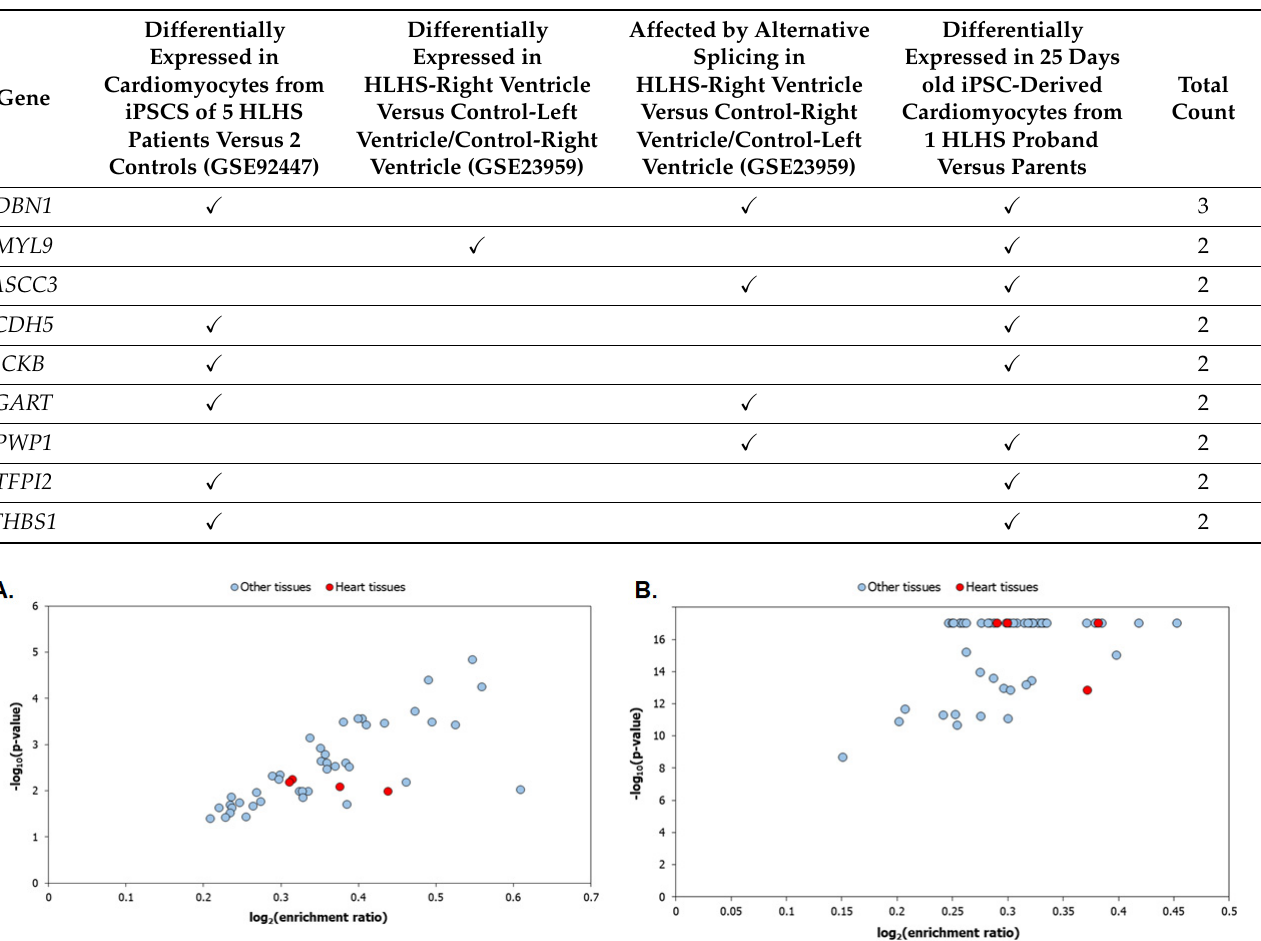
Table 1. Novel interactors in the hypoplastic left heart syndrome (HLHS) interactome with biological evidence related to HLHS: The table shows those novel interactors of HLHS-associated genes that have 2 or more HLHS-related biological evidence associated with them. The complete list of biological evidence for all the genes in the interactome can be found in Data File S9. We studied the tissue-specific expression of the HLHS interactome genes using RNA- seq data of 53 postnatal human tissues obtained from GTEx [39], with and without the inclusion of housekeeping genes from the Human Protein Atlas [40]. An expression of more than nine transcripts per million (TPM) is considered high/medium expression. A